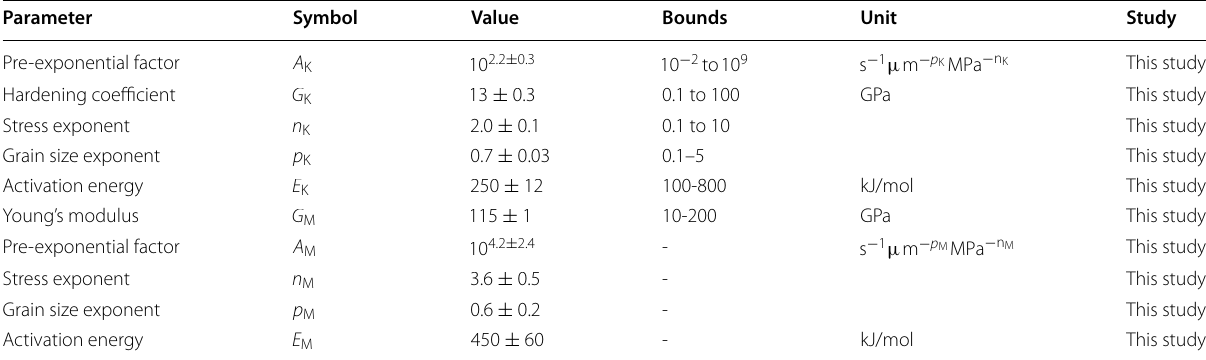
Table 5 Flow law parameters of wet dunites determined from the constant-strain rate experimental data. The bounds column contains the lower and upper bounds used for Gibbs sampling. The errors are for one standard deviation